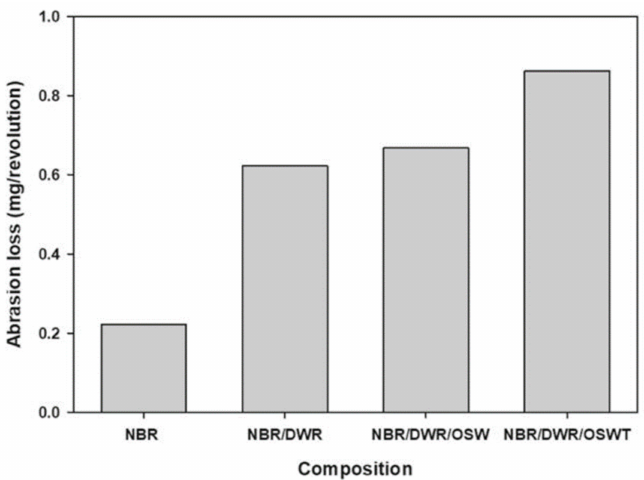
Figure 16. Abrasion resistance of NBR and NBR/DWR (70/30) and NBR/DWR reinforced with treated or untreated olive stones waste